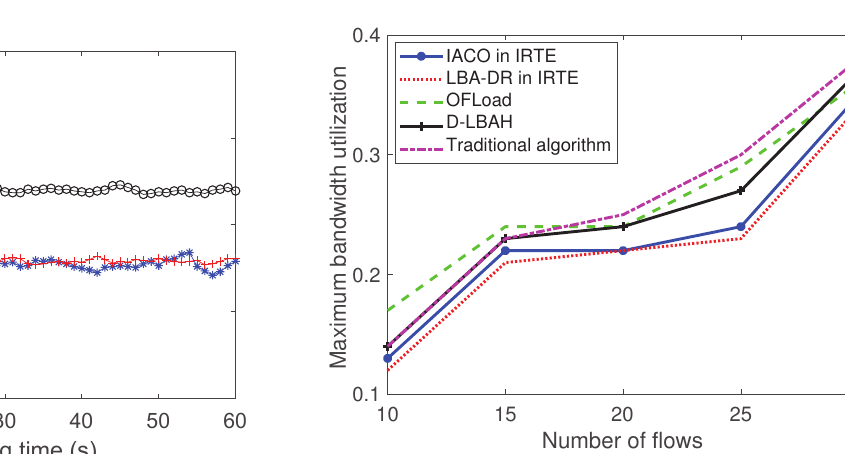
Fig. 4 CPU utilization in Bellsouth.